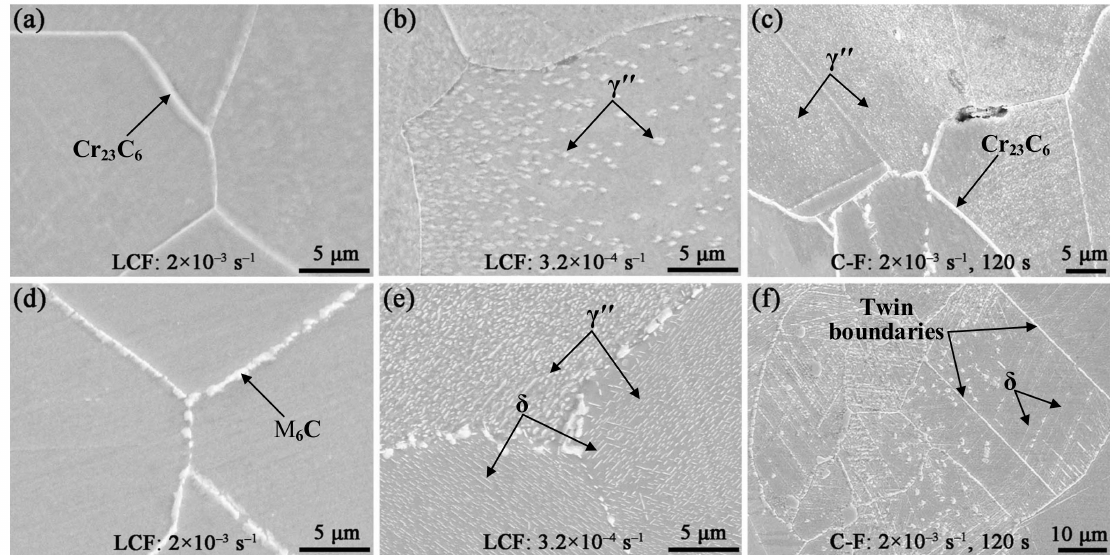
Figure 8. Microstructures of the fractured specimens: ( a – c ) 700 ◦ C; ( d – f ) 800 ◦ C. The precipitates were seldom observed by SEM in the fatigue specimens under the strain rate of 2 × 10 − 3 s − 1 . However, fine precipitates, as well as dislocations-entangled precipitates, were found by TEM, as shown in Figure 9a–c. Moreover, Figure 9d,e illustrate . ε = 3.2 × 10 − 4 s − 1 ) the precipitate morphology in the fractured specimens of the LCF test ( and C–F test ( t h = 60 s) at 800 ◦ C, respectively. The sizes of γ (cid:48)(cid:48) precipitates in Figure 9d,e were about 7.1 and 32.6 times larger than those in Figure 9b, respectively. It can be seen from the electron diffraction patterns in Figure 9 that the granular and lenticular precipitates were identified as the γ (cid:48)(cid:48) phase, and the needle-like precipitates were the δ phase.